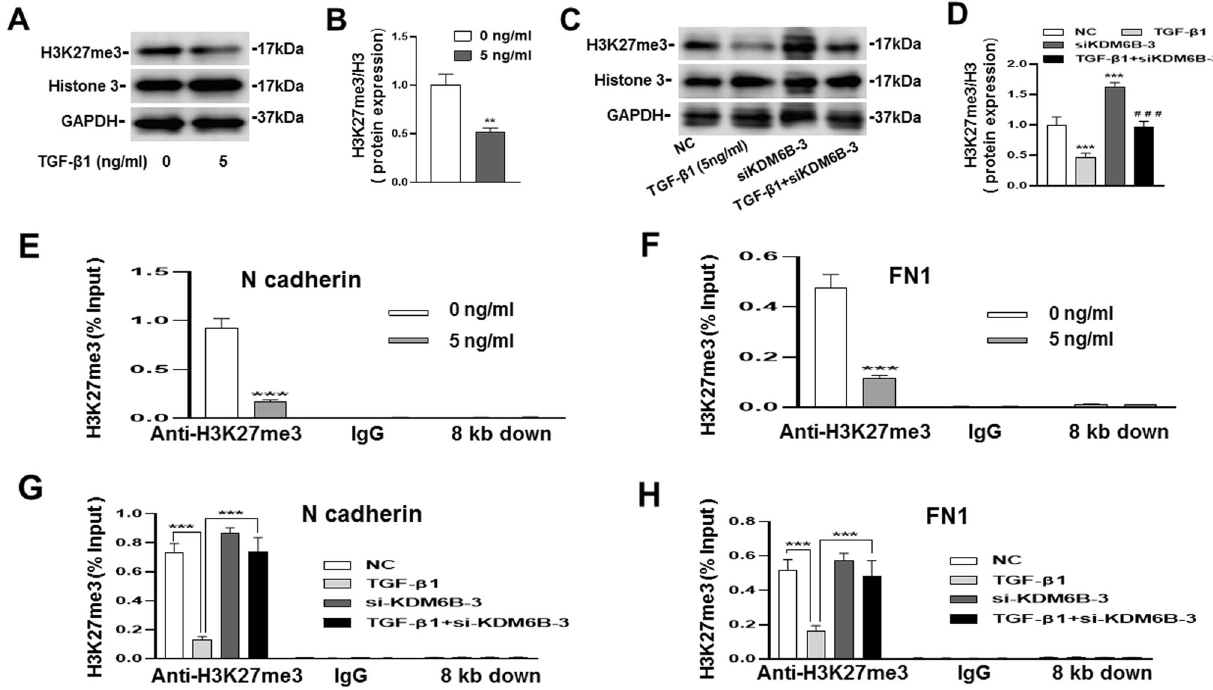
Fig. 4 TGF- β 1 regulated the gene expression by removing H3K27me3 in the promoter region through KDM6B. A – D The results of western blotting showed that the protein expression of H3K27me3 was downregulated by TGF- β 1, but this inhibitory effect can be partially reversed by silencing of KDM6B. E , F The levels of H3K27me3 in the promoter regions of N cadherin and FN1 were removed by TGF- β 1, IgG and 8 kb downstream of the transcription start site were used as negative control. G , H The siRNA-KDM6B could reverse the decreased levels of H3K27me3 at the promoter regions of N cadherin, and FN1 caused by TGF- β 1. ( ** P < 0.01, *** P <0.001 in comparison with the control group, ### P <0.001 in comparison with TGF - β 1 group. All experiments were repeated three times independently. All error bars ± standard deviation.).